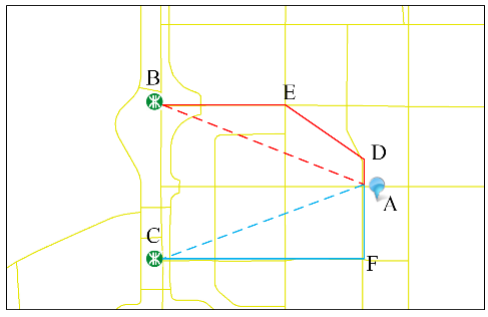
Figure 7. Road network in Shenzhen.